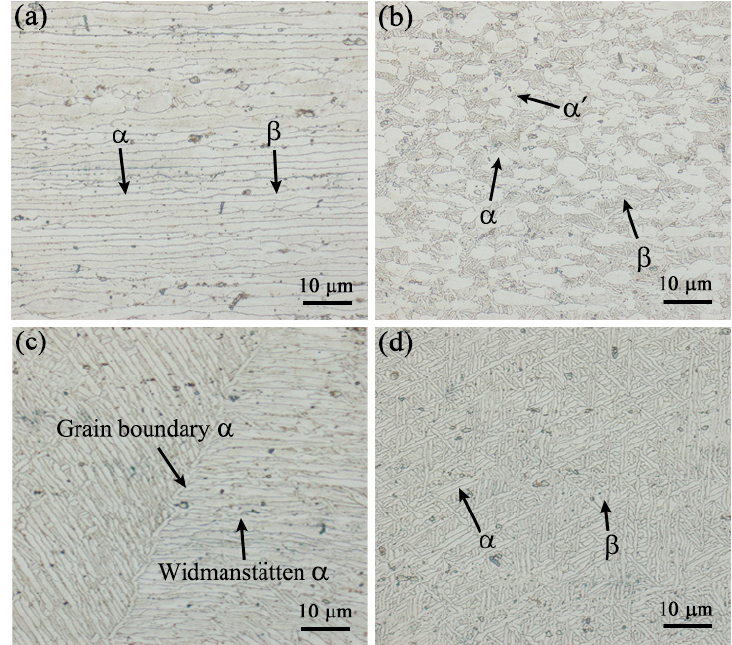
Figure 4. Microstructures of the ( a ) BM, ( b ) HAZ, and ( c , d ) fusion zone (FZ).